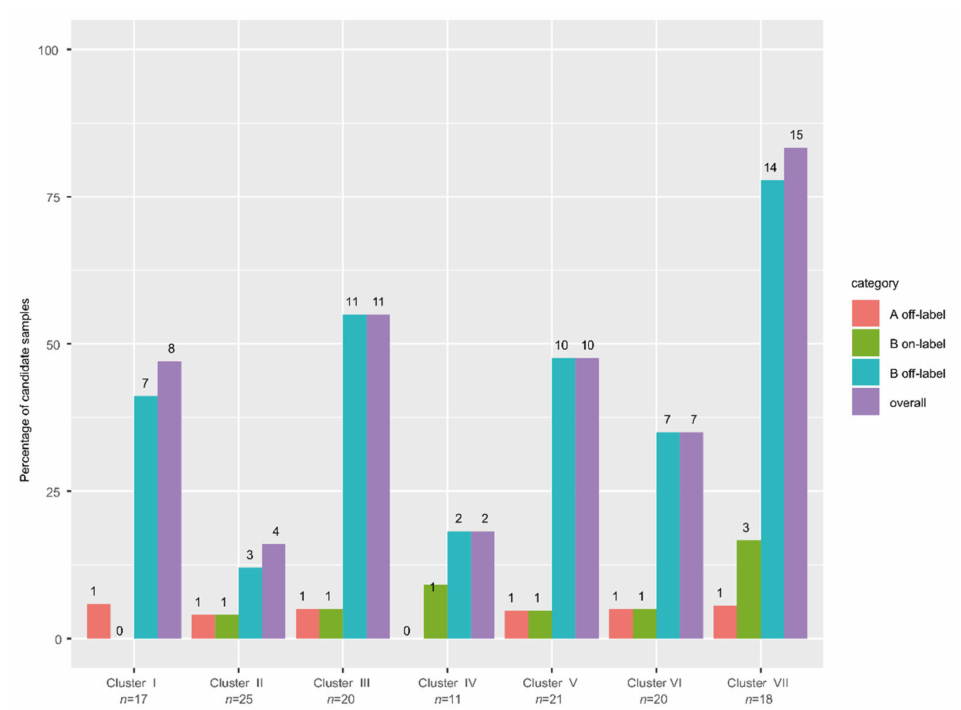
Figure 5. Actionability per cluster. The percentage of samples per cluster with an actionable target (level A/B, on/off label). Purple bar indicates the number of samples per cluster with any actionable target. Most targets are classified as level B off-label. Cluster VII yielded the highest percentage of samples with an actionable